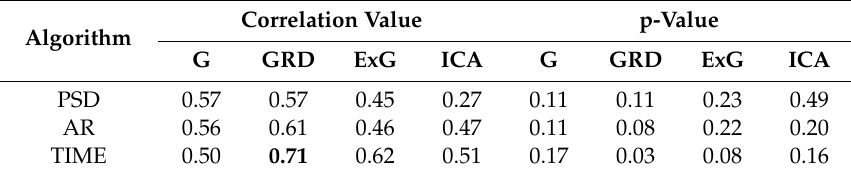
Table A11. The Pearson’s correlation values between the sRate and the average scene lighting. Algorithm